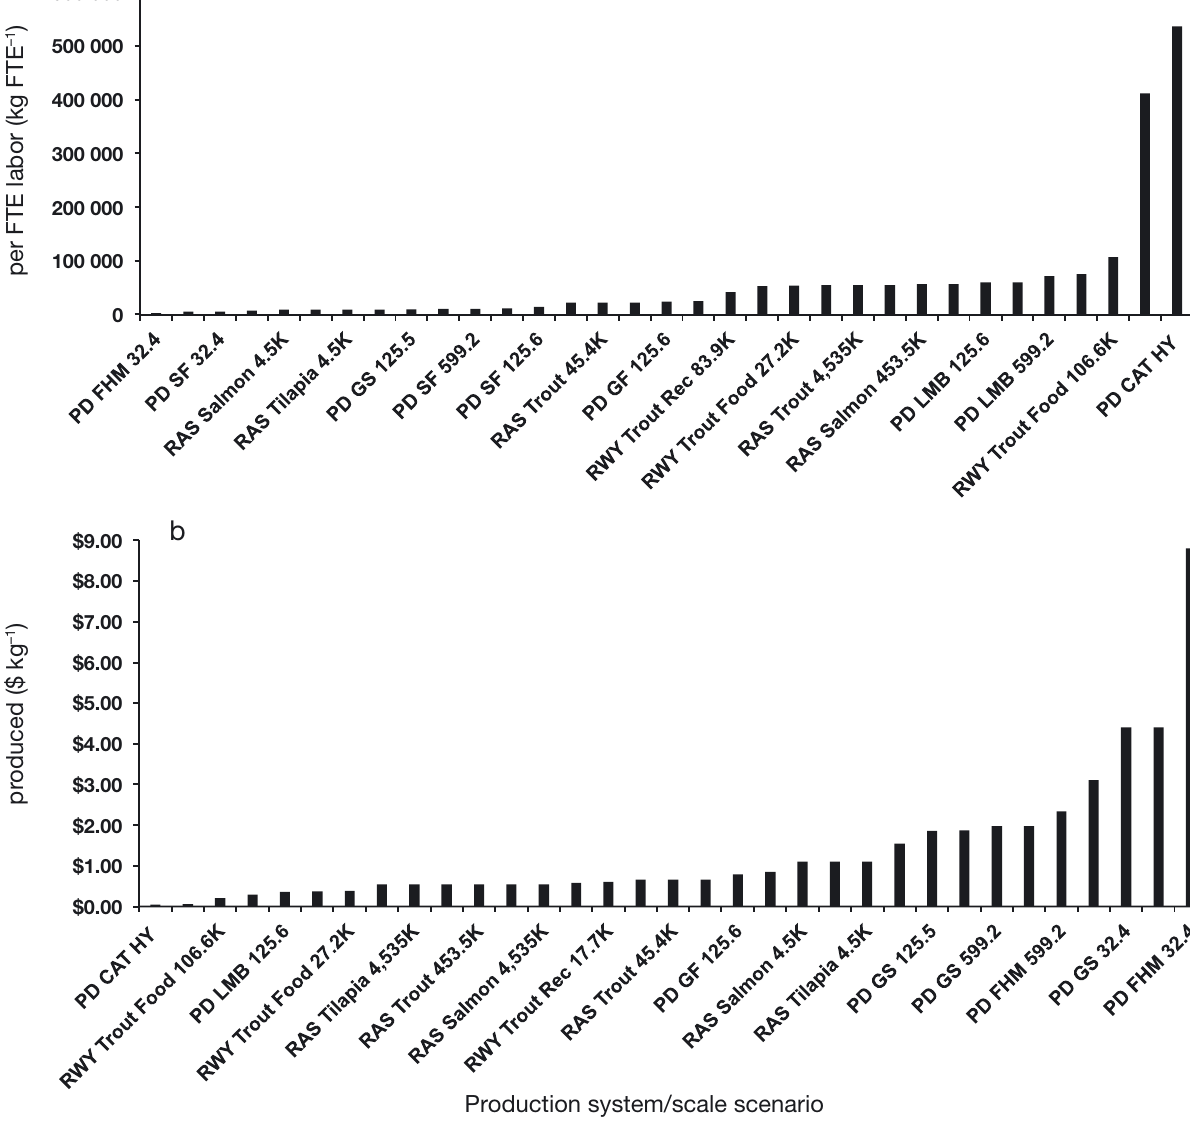
Fig. 5. (a) Labor productivity and (b) land cost across production systems. Pond-based farm sizes: 32, 124, and 592 ha; Trout raceway production scales were 27.2K, 106.6K, 17.7K, 83.9K: production levels of 27200, 106600, 17700, and 83900 kg yr −1 ); FTE: full-time equivalent; other abbreviations as in Fig.